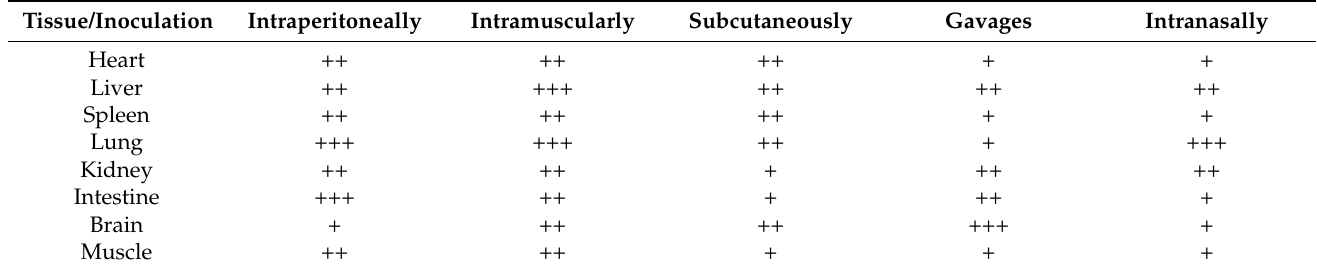
Table 1. Severity of histopathological lesions in mice experimentally infected with CEV-JL14 with different routes.